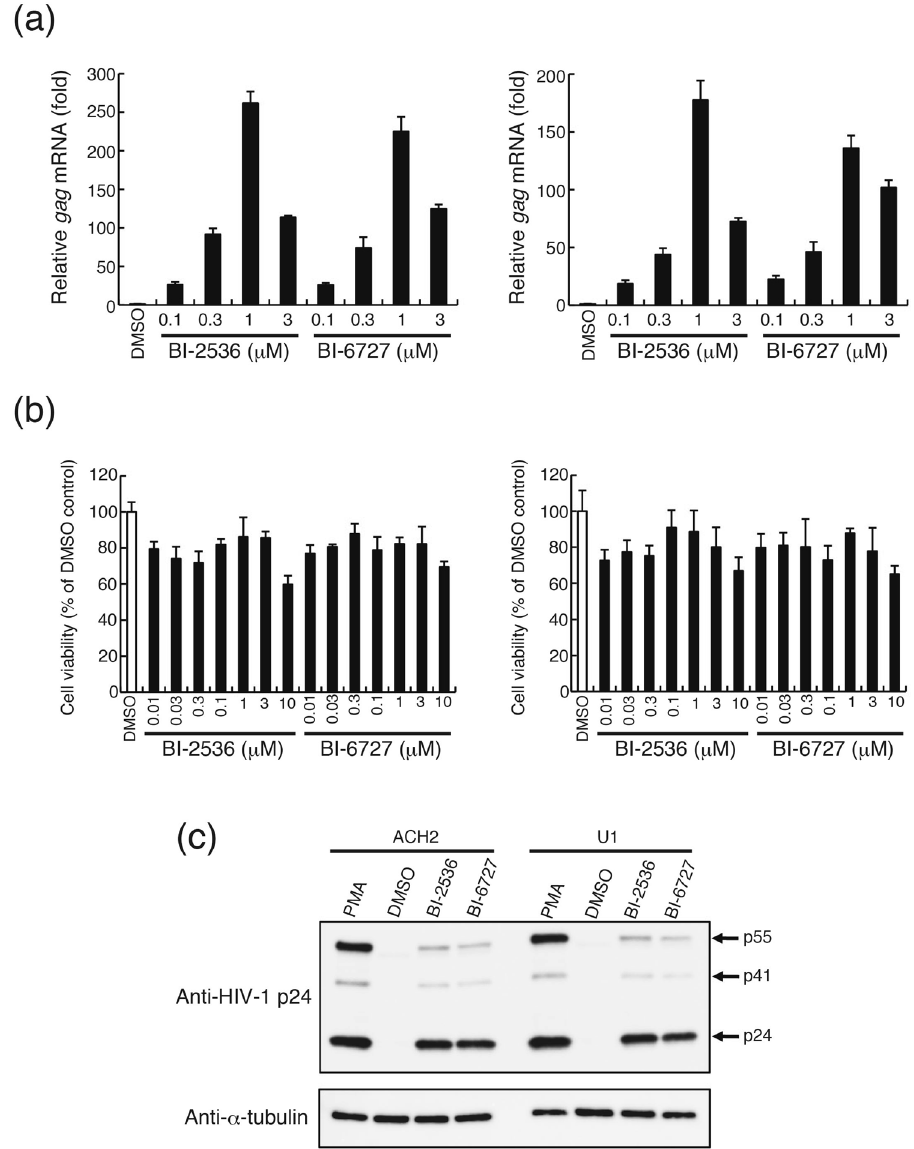
Figure 3. BI-2536 and BI-6727 reactivate HIV-1 provirus in the latently infected model cells. ( a ) ACH2 and U1 cells were cultured in the presence of 0.1% DMSO, BI-2536 or BI-6727 at the indicated concentrations for 16 hours. HIV-1 gag mRNA expression was measured by quantitative RT-PCR. Fold induction of gag mRNA normalized by gapdh mRNA expression was determined and compared with DMSO-treated cells. Each value is shown as a mean ± SD of triplicate determinations. ( b ) ACH2 and U1 cells were cultured in 0.1% DMSO only or in the presence of BI-2536 or BI-6727 at the indicated concentrations for 24 hours. Cell viability was measured by a WST-8 assay and shown as a percentage of that of DMSO control cells. Each value is shown as a mean ± standard deviation (SD) for triplicate samples. ( c ) ACH2 and U1 cells were incubated in the presence of 0.1% DMSO, 10 ng/mL PMA, 1 μ M BI-2536, or 1 μ M BI-6727 for 24 hours. Cell lysates were immunoblotted with anti-HIV-1 p24 and anti- α -tubulin antibodies. The arrows indicate bands of viral p24, p41, and p55. The cropped images of the blots are shown. The uncropped images are shown in Supplementary Fig.